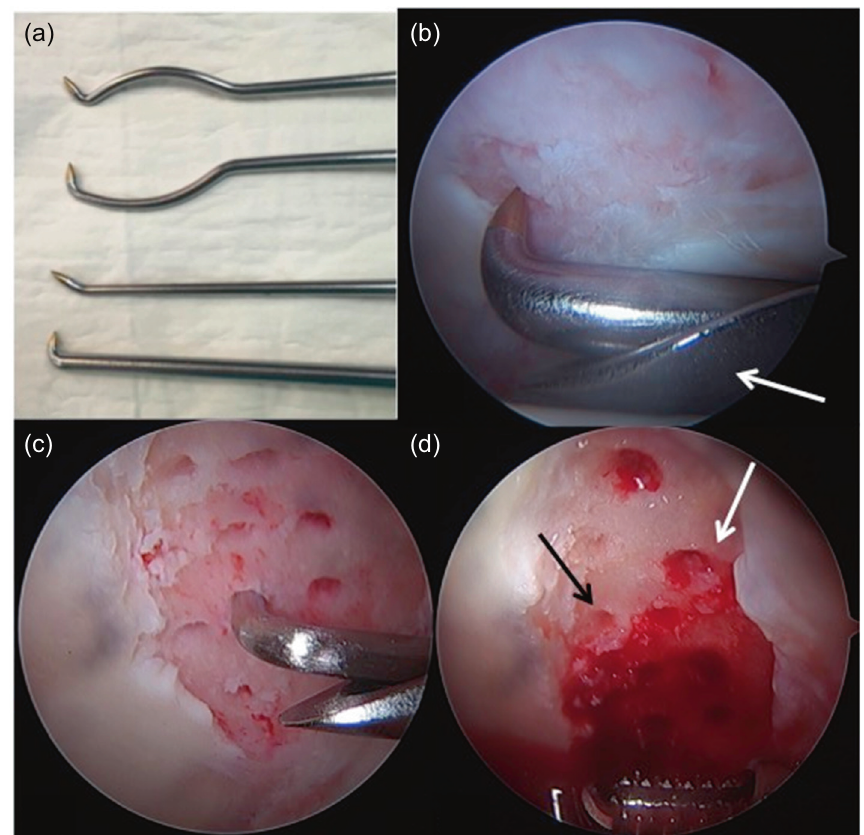
Figure 4. (a) There are different designs of arthroscopic awls with diverse angles to compensate the mechanical difficulty performing microfractures in the reduced space of the hip joint. (b) When making the impact with the mallet on the ‘‘arthroscopic awl’’ there is a risk of sliding forward creating grooves instead of perforations. To prevent this, it is beneficial to use the supplementary support on a hemi-cannula (arrow). (c) This protects the cartilage from the femoral head and allows pressuring against the acetabular surface, achieving a greater penetration of the awl at the moment of impact preventing the creation of grooves on the surface. (d) Once the microfractures have been completed, articular irrigation can be suspended to verify adequate bleeding from the perforations (white arrow) and to further deepen the perforations where there is still no bleeding (black arrow).